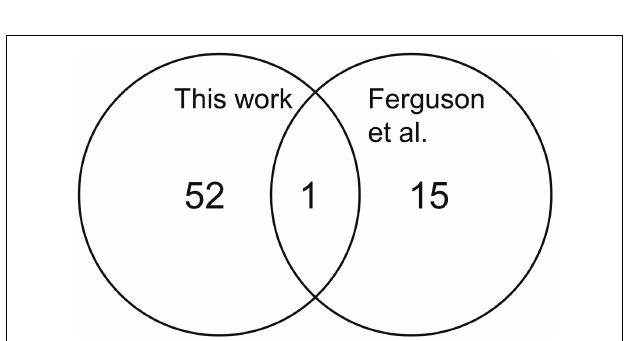
FIGURE 3 |TaqMan quantitative PCR validation of expression levels of IGF1R, MUC20, RRAD, PSPH, and PSPHL in endometrial cancers from Caucasian ( n =14) andAfrican-American ( n =10) women is shown in top